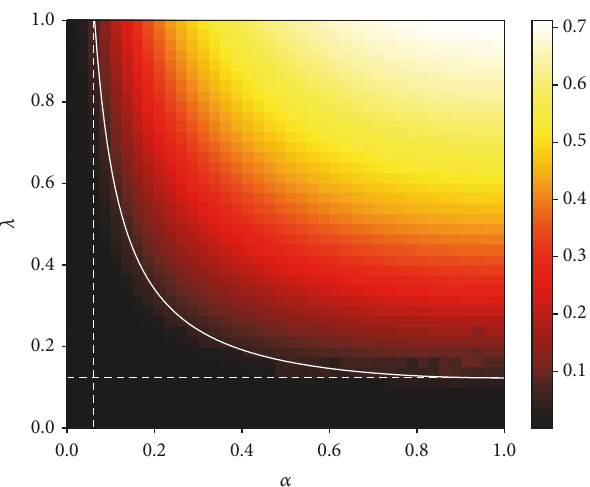
Figure 2: Final rumor transmission scale 𝑅 with different 𝛼 and 𝜆 . Solid line matches the 𝜆 = ⟨𝑘⟩/⟨𝑘 2 ⟩ ∗ 𝛿/(2𝛼 − 𝛼 2 ) . Horizontal dashed line consists with 𝜆 = ⟨𝑘⟩/⟨𝑘 2 ⟩ ∗ 𝛿 , and vertical dashed line corresponds to 𝛼 = 1 − √1 − 𝛿⟨𝑘⟩/⟨𝑘 2 ⟩